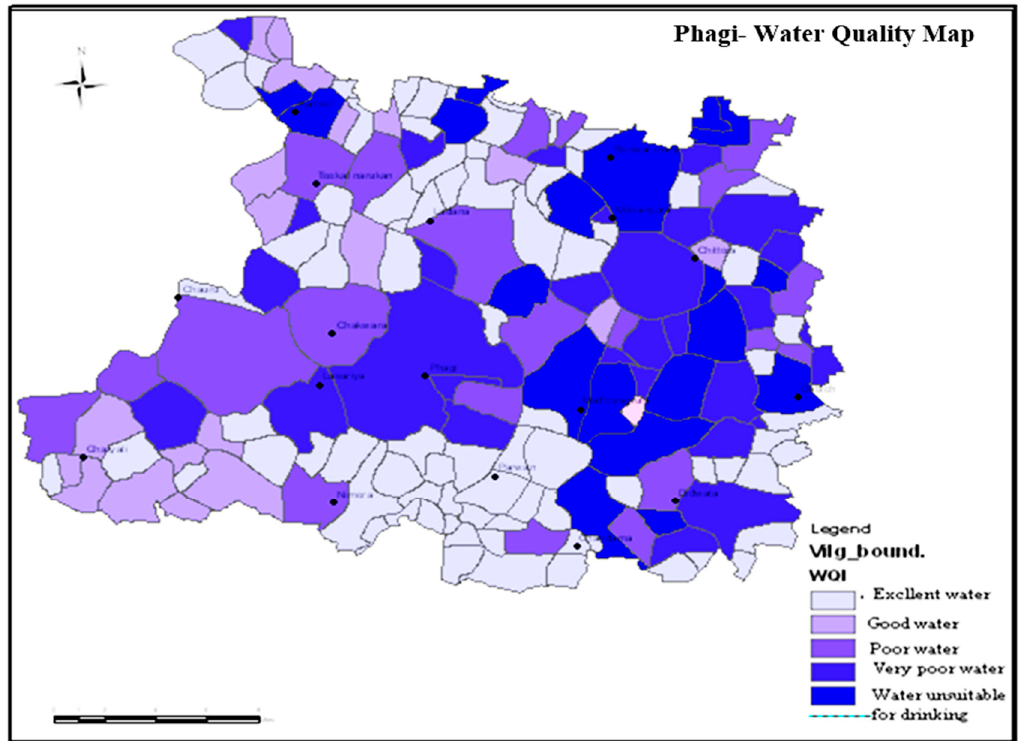
Figure 5. Water quality map using WQI of 89 Villages in the Phagi Tehsil (Source—Primary Data).